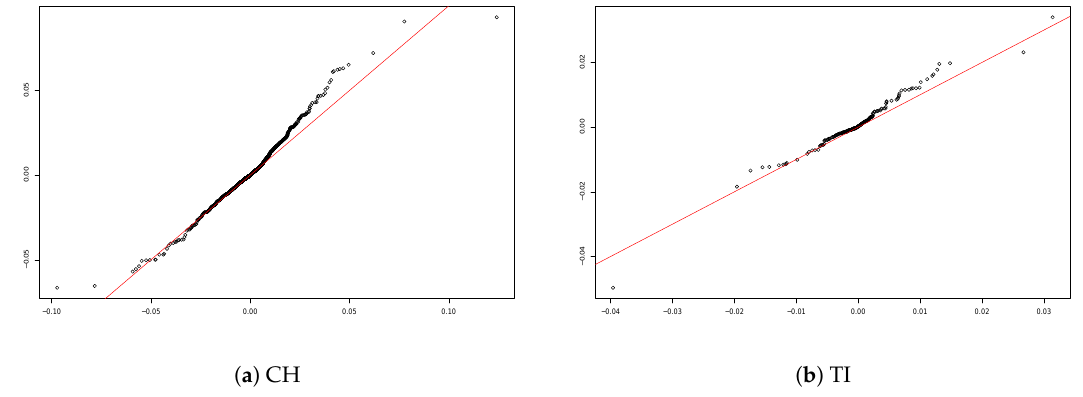
Figure 15. QQ-plot of Two-sided lognormally distributed residuals versus theoretical